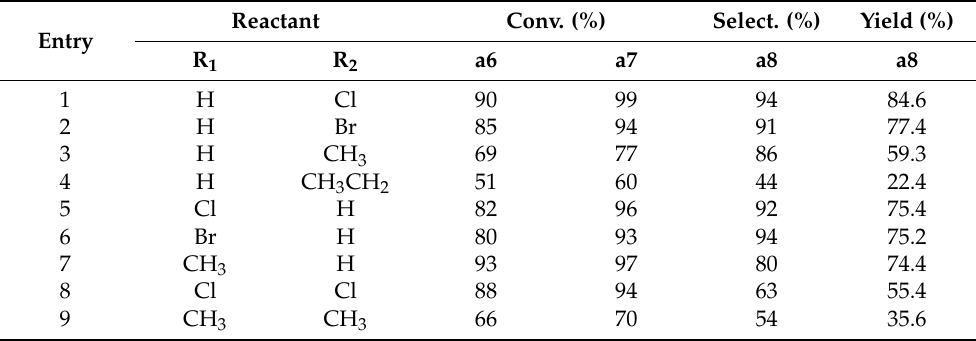
Figure 6. Photocatalytic One-Pot Synthesis of Imine from Nitroaromatics and Aromatic Alcohols. Table 3. The photocatalytic synthesis of Imine from several other substrates over the Co 0.6 Ni 0.4 S 2 /rGO catalyst.